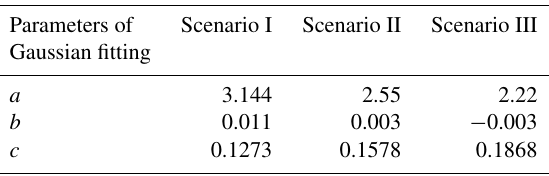
Table 4. The parameters of Gaussian fitting, which are used by the frequentist method to account for I – D